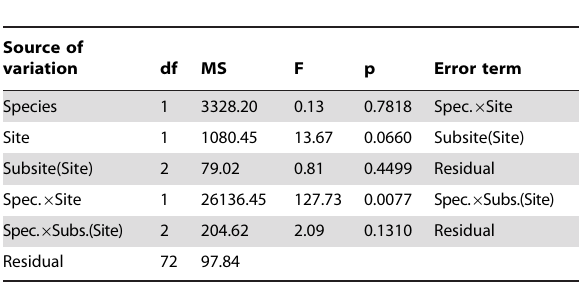
Table 1. Three-factor nested ANOVA (Sub-site nested in Site; Species a fixed factor) of Korcak B patchiness exponent of mussels in the mid